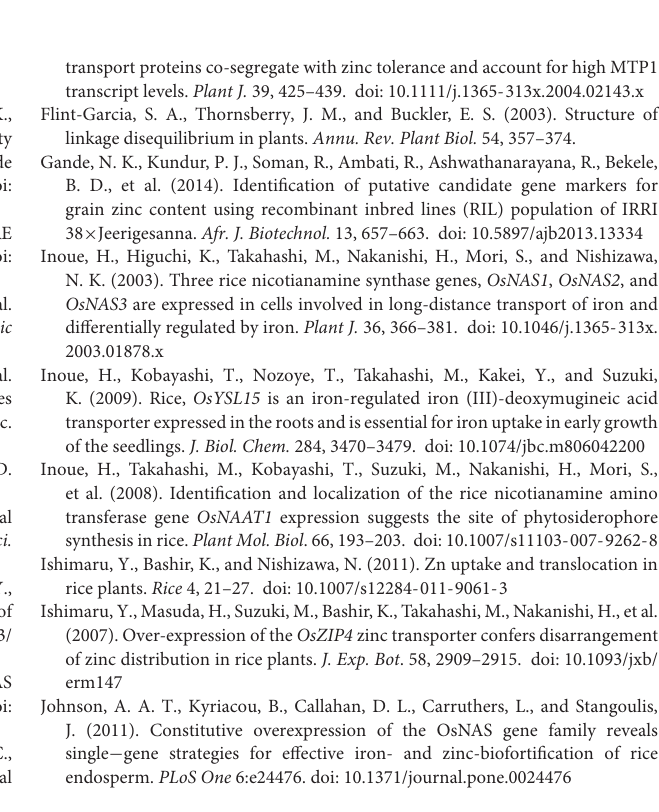
Supplementary Table 3 | Haplotype information for grain Zn content genes found in the SC cultivars. Supplementary Table 4 | Distribution of haplotype frequencies for the 65 selected zinc responsive genes. Supplementary Table 5 | List of MAGIC-DC1 lines used in this study. Supplementary Table 6 | Parental lines used to develop DC1 MAGIC-DC1